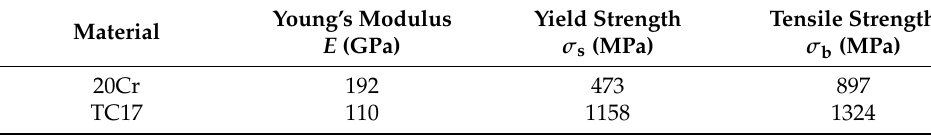
Table 1. Mechanical properties of experimental materials.